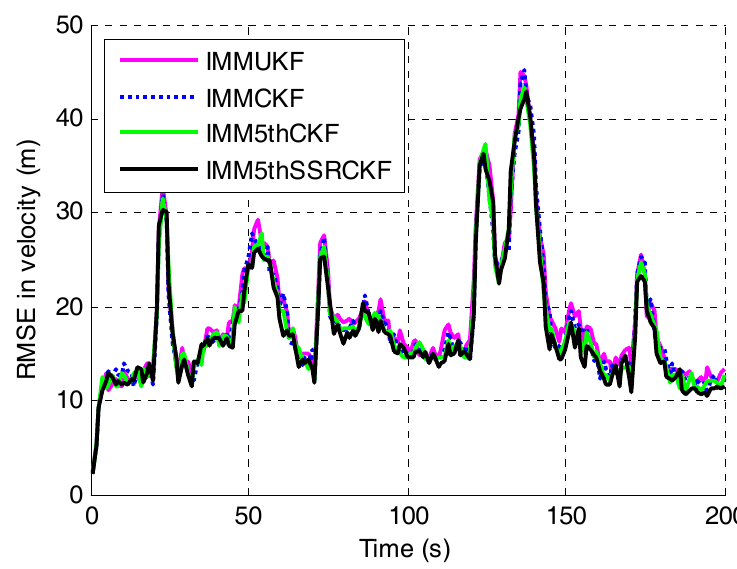
Figure 4. RMSE in velocity versus time step.